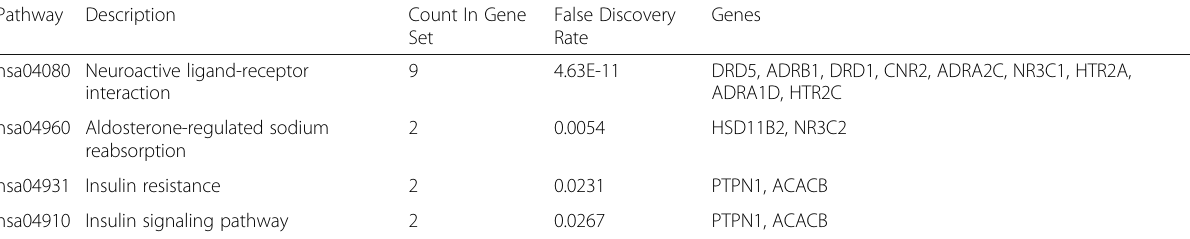
False Discovery Genes Set Rate 9 4.63E-11 DRD5, ADRB1, DRD1, CNR2, ADRA2C, NR3C1, HTR2A, ADRA1D, HTR2C